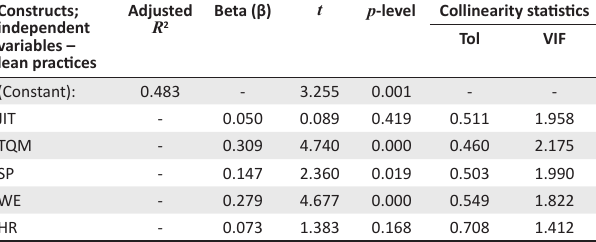
TABLE 4: Regression analysis of lean practices and lean culture. Constructs; independent variables – lean practices